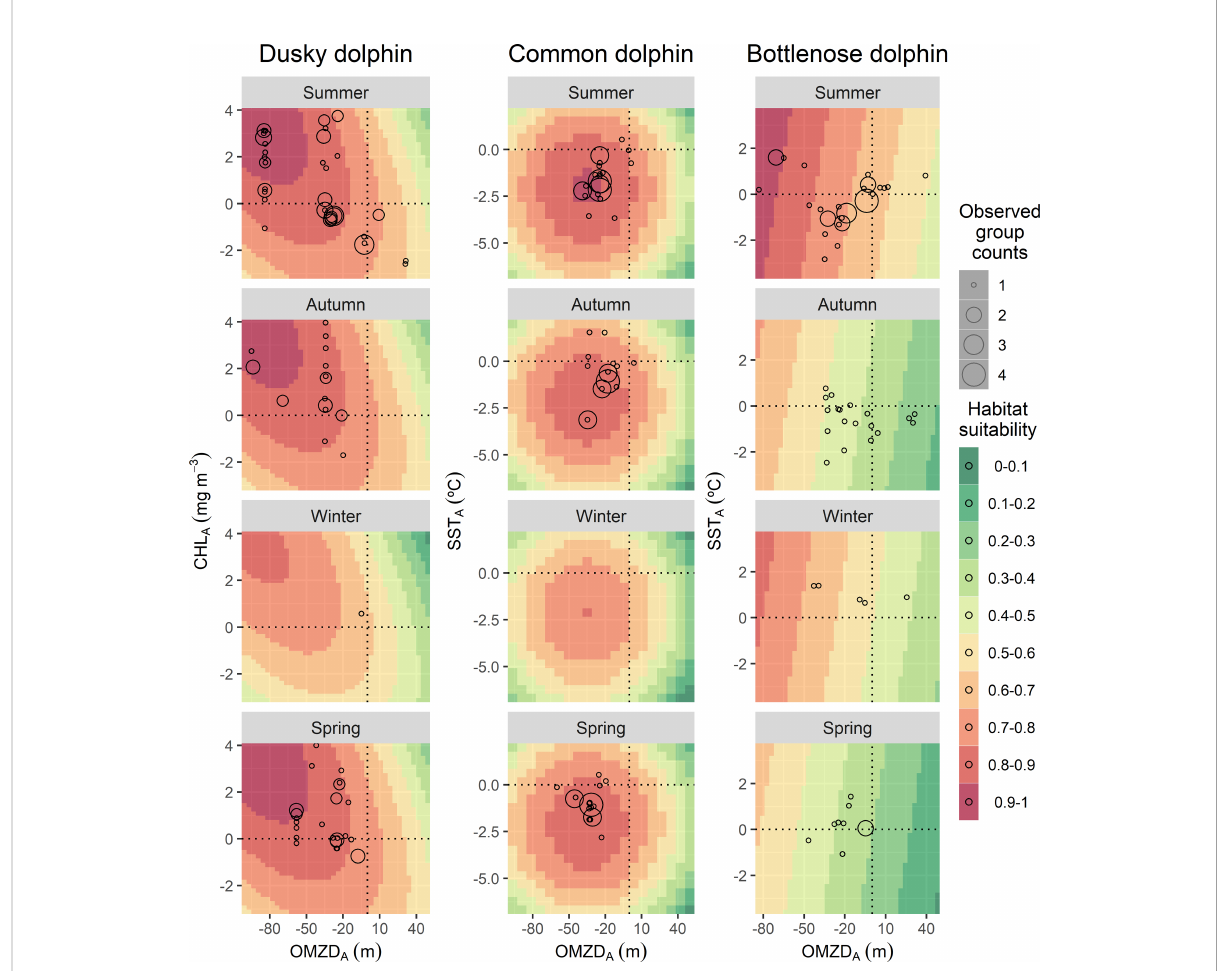
FIGURE 1 Predicted values of habitat suitability of dolphin species in the northern Humboldt Current System for a theoretical environmental space, based on the covariates included in the best models: the oxygen minimum zone depth spatial anomaly (OMZD A ), the remotely sensed chlorophyll- a concentration spatial anomaly (CHL A ) and the remotely sensed seas surface temperature anomaly (SST A ). Empty circle sizes represent the observed group counts in each sample unit (i.e.,